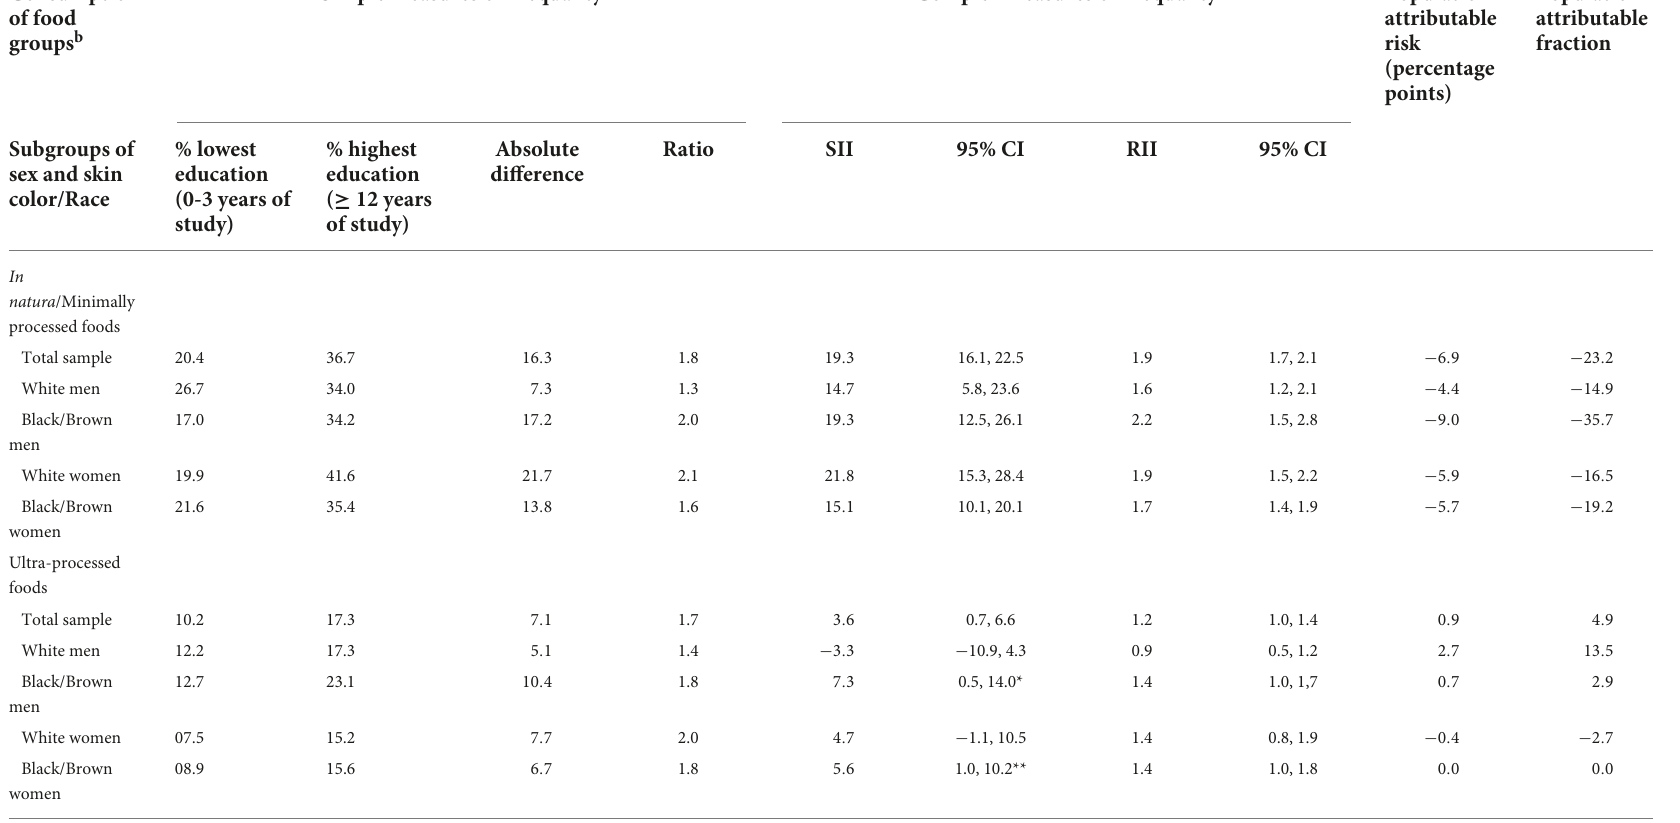
Simple measures of inequality Complex measures of inequality Population